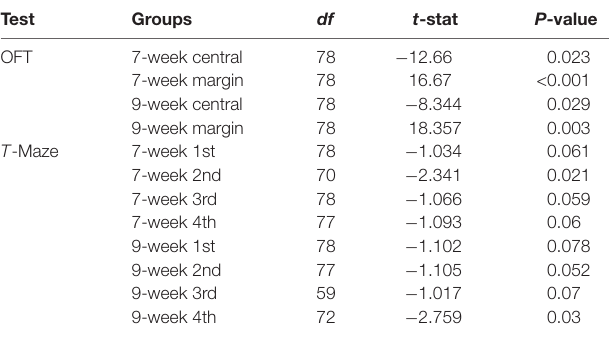
TABLE 4 | The post hoc t -tests for OFT and T -maze ANOVAs. Test